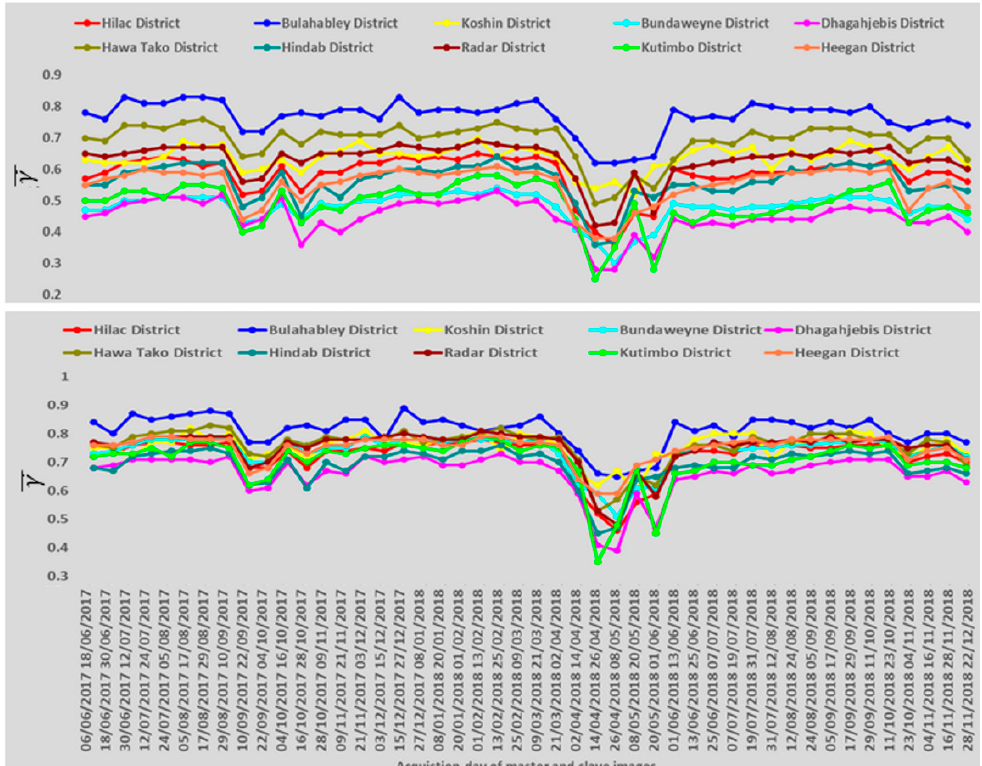
Figure 5. Temporal trend of the mean value of the coherence in the various districts of Beletweyne (upper panel) and in the PSs located in the districts (lower panel). The period June 2017–December 2018 is considered.